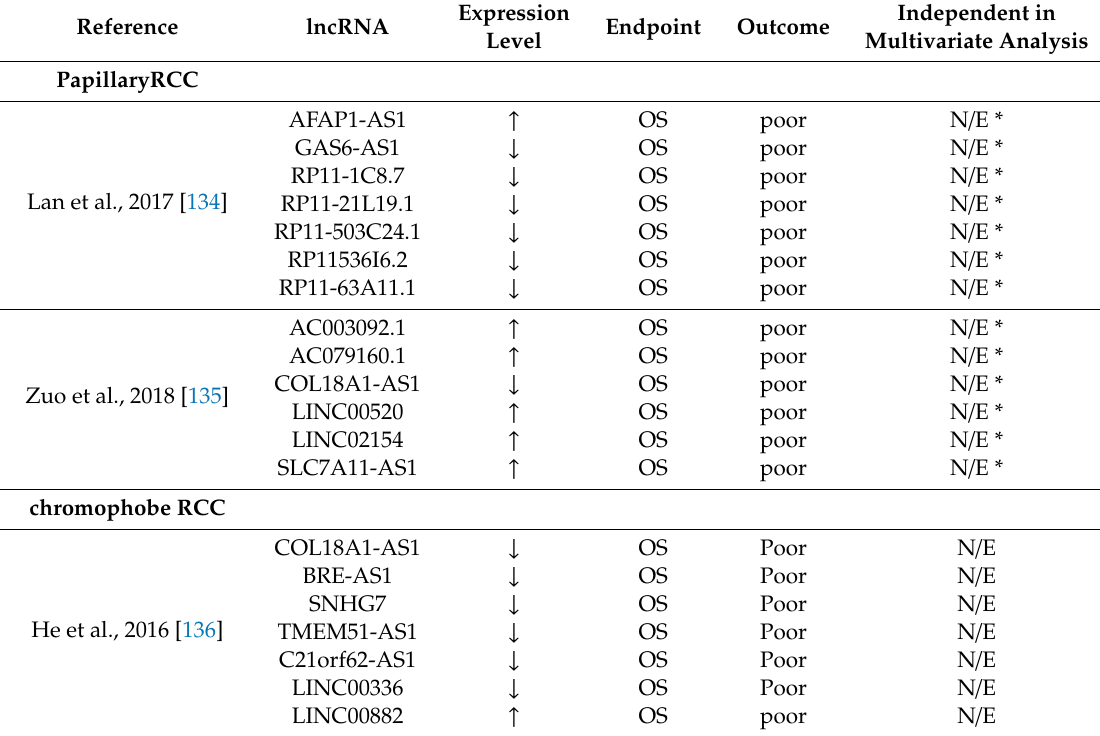
Table 2. lncRNAs significantly associated with outcomes in